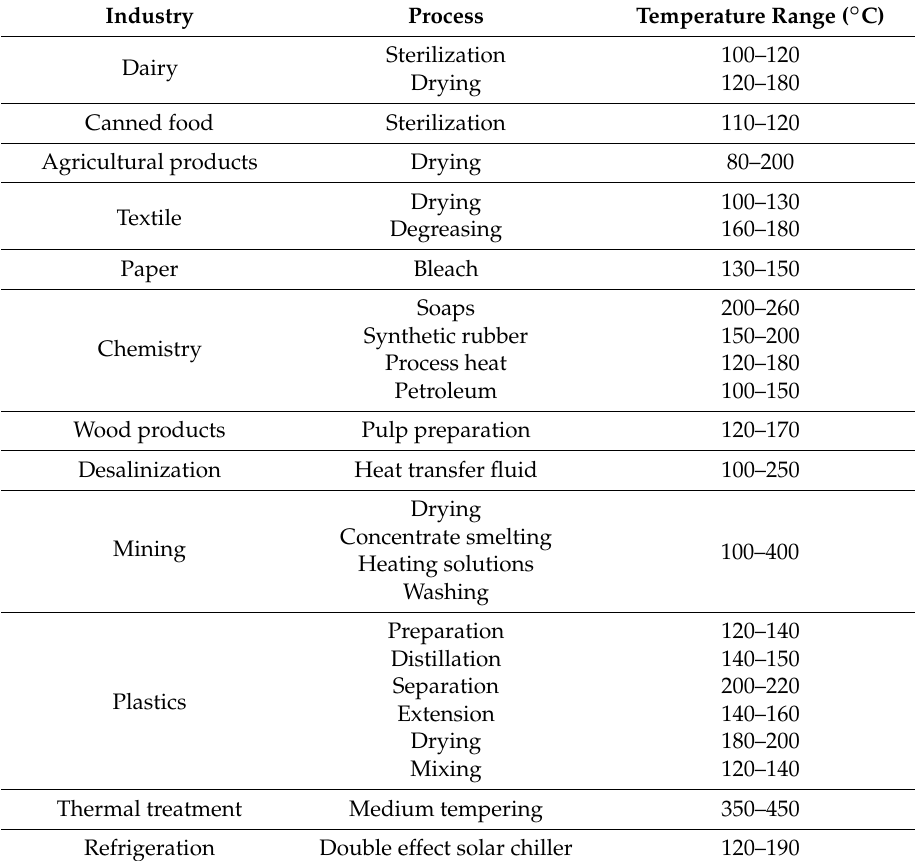
Table 1. Industrial processes temperature range